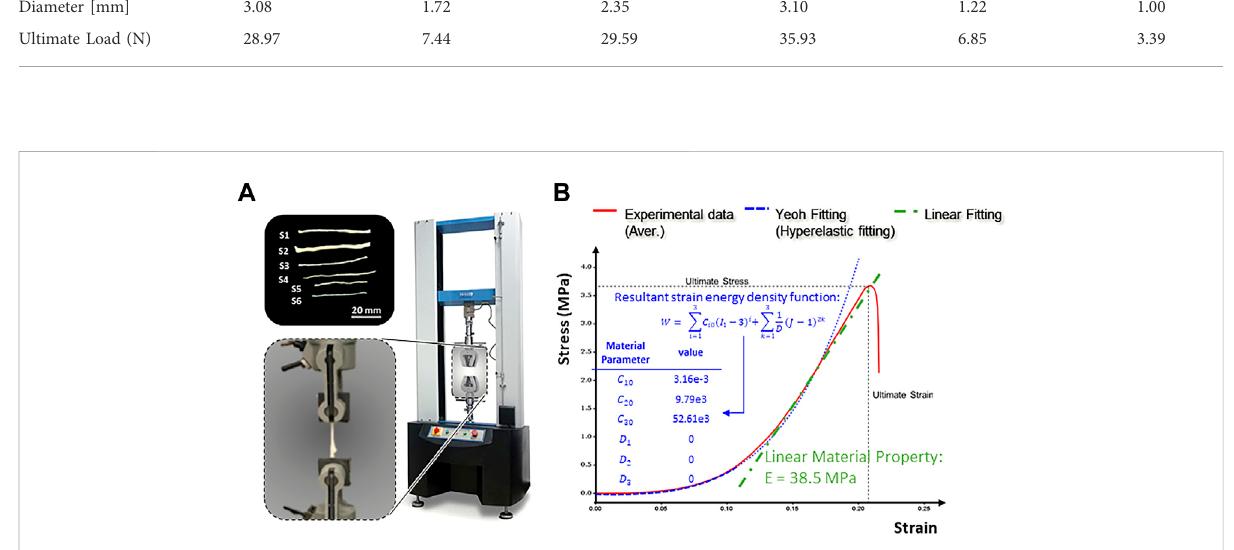
FIGURE 4 Tensile testing of human peripheral nerve fascicles. (A) Experimental setup. (B) Typical stress-strain curve obtained after tensile testing of the peripheral nerve